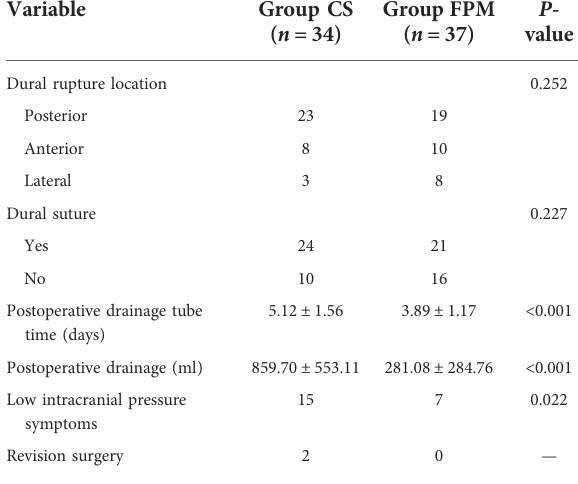
TABLE 3 Clinical date about CSF leakage in group CS and group FPM.